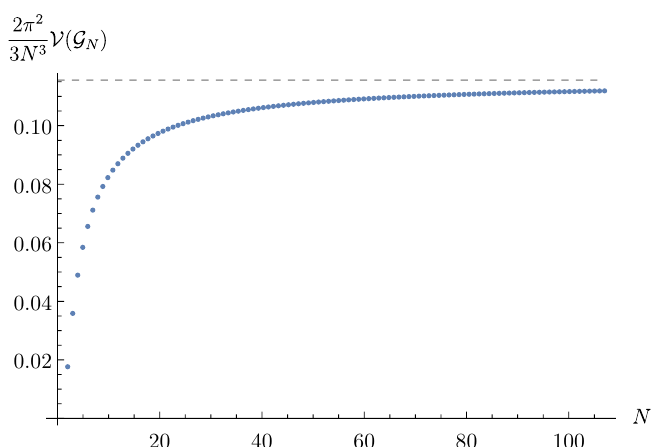
Figure 3. A plot of 2 π 2 V ( G N ) as a function of N for N ≤ 107 . This matches well onto large N 3 N 3 asymptotics